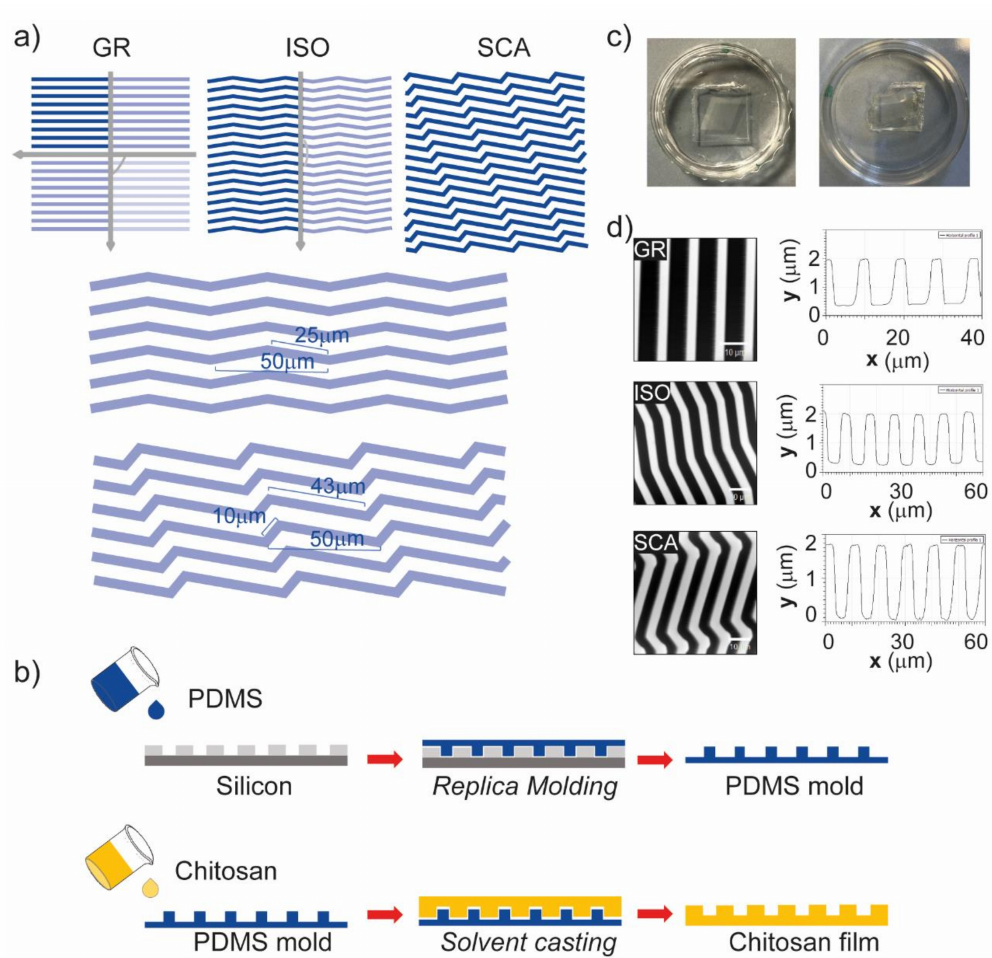
Figure 1. Chitosan microstructured membrane development. ( a ) CAD designs of the three patterns: gratings (GR), with two symmetry axes (grey arrows); isosceles triangles (ISO), with one symmetry axis; and scalene triangles (SCA), with no symmetry axis. All of the patterns had 4 µ m ridges and 6 µ m grooves; in detail, the ISO has triangles had a 50 µ m base and 25 µ m sides (minor angle 10 ◦ ), the the SCA had triangles with a 50 µ m base and 10 µ m and 43 µ m sides (minor angle 10 ◦ ). ( b ) The microtextured chitosan membrane fabrication process with two molds by replica molding and solvent casting. ( c ) Images of a PDMS mold and a chitosan micropatterned membrane. ( d ) AFM measurements and the extracted profile of the micropatterned chitosan membranes. From the top: GR, ISO and SCA. Scale bar = 10 µ